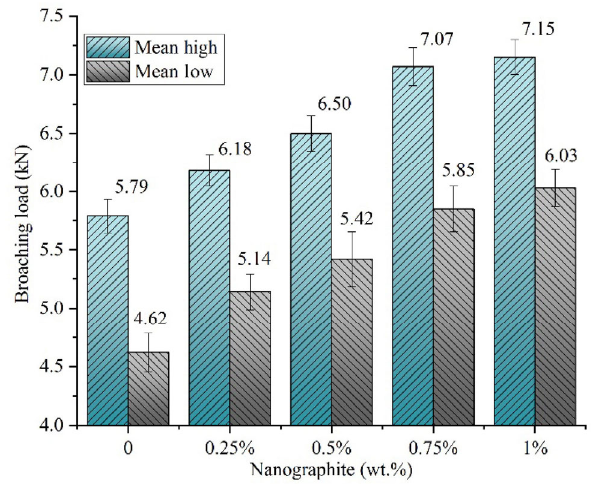
Fig. 5 Broaching load for different concentrations of nanographite in the WOS-G cutting